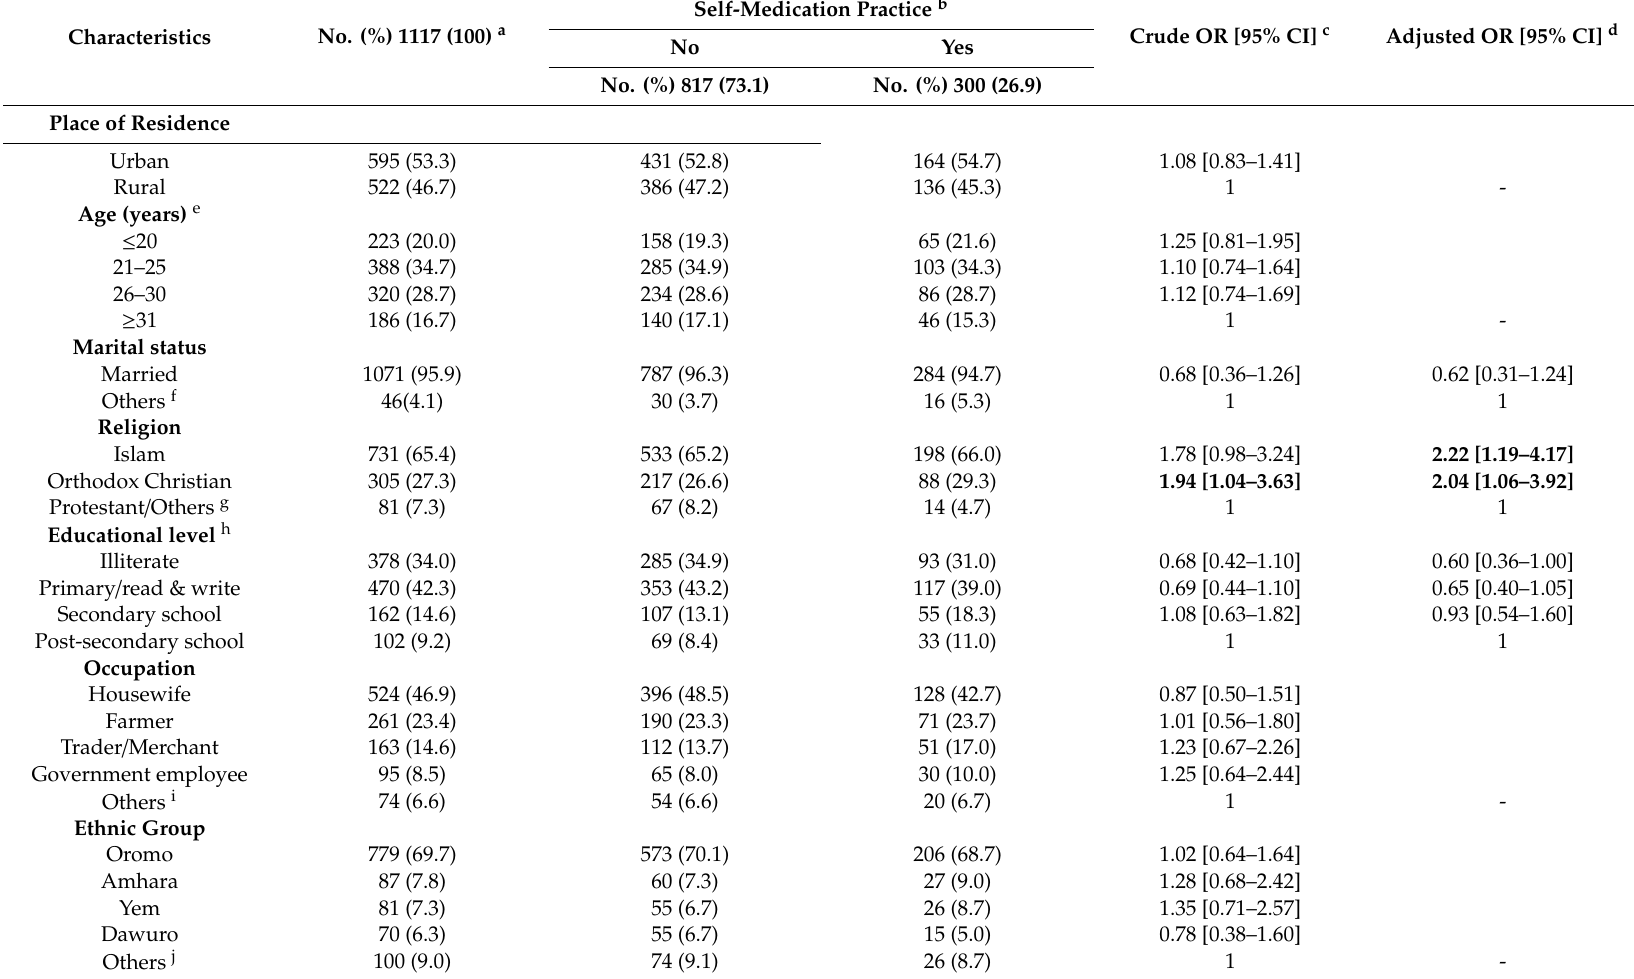
Table 1. Characteristics of pregnant women according to self-medication practice prior to admission to JUMC, Ethiopia.